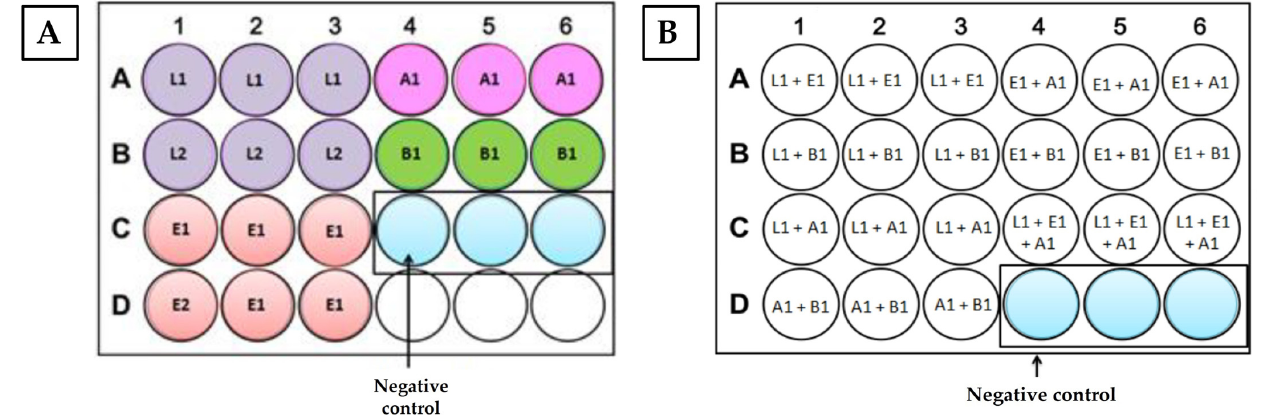
Figure 2. Schematic organization of the 24-well plate with the pure bacterial suspensions ( A )